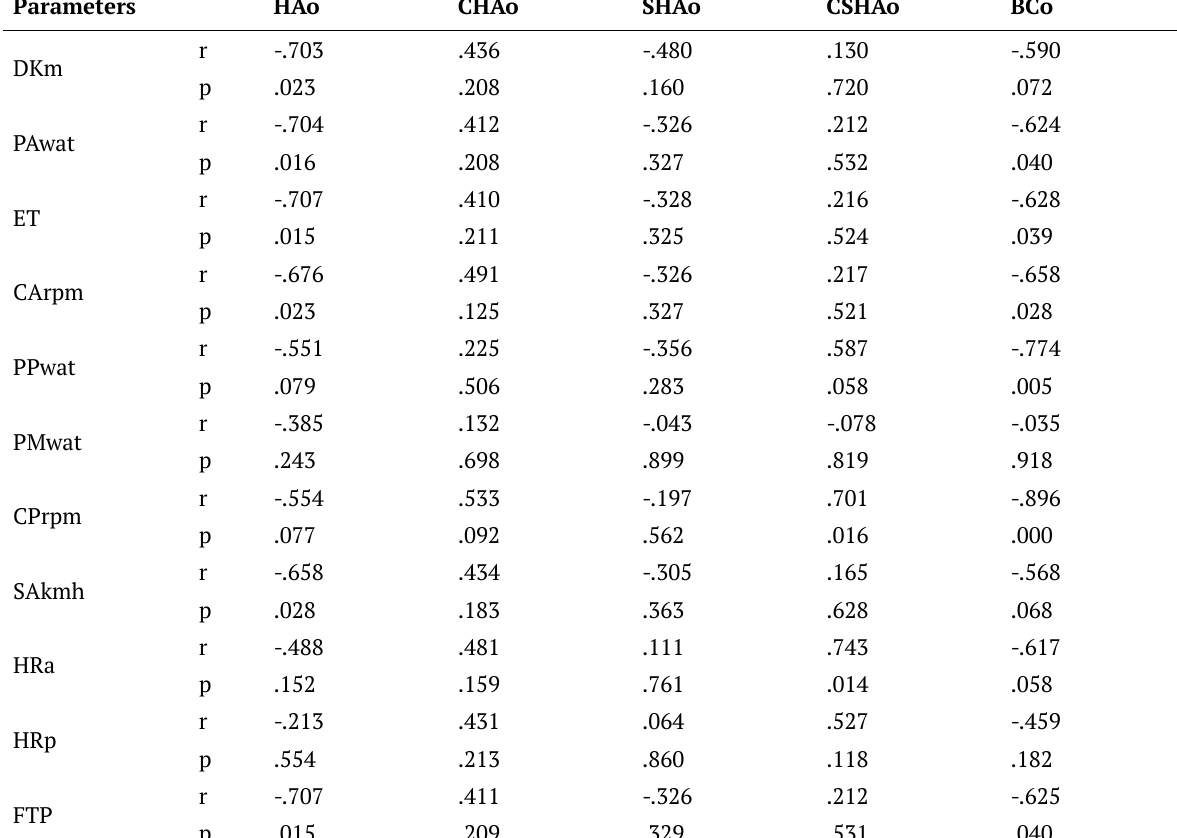
Table 3. Correlations between FTP test parameters and angle degrees that occur during cycling Parameters HAo CHAo SHAo CSHAo BCo -.703 DKm .208 .720